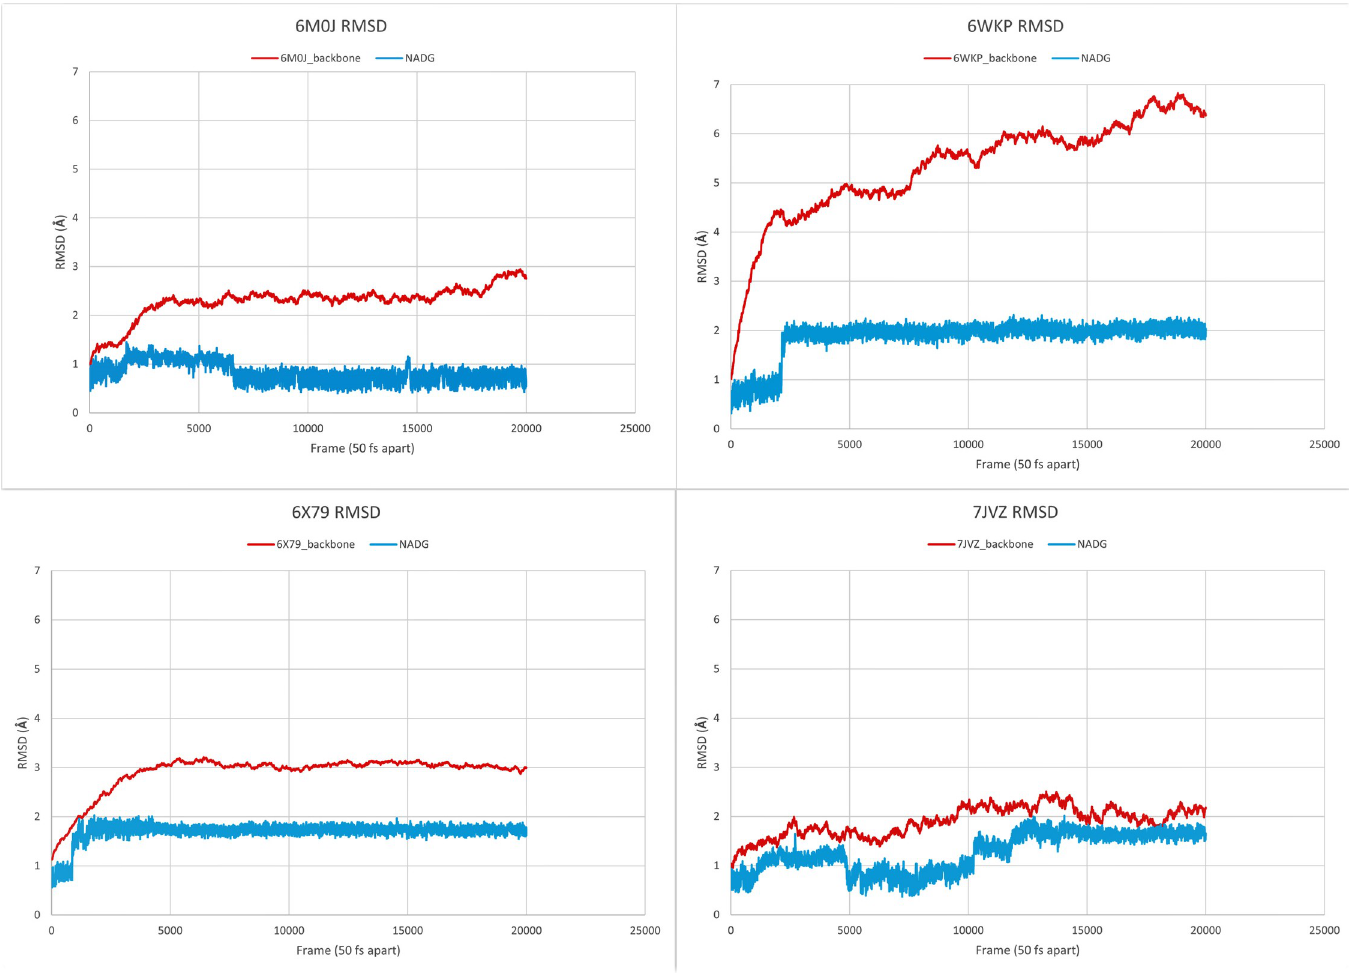
Fig 6. Analysis of molecular dynamics trajectory. Backbone RMSD ( Å ) along the Y-axis and frames (50 fs distance between any 2 frames) along the X-axis for each protein-ligand complex 1.000.000 production runs. Redline indicating protein backbone RMSD and light blue indicating ligand RMSD.